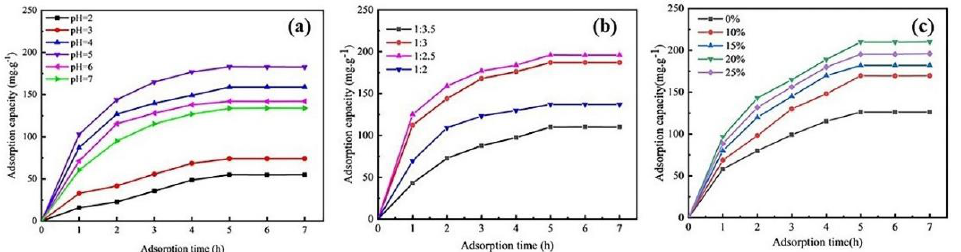
Figure 6. Effects of the solution pH ( a ), PEG/MeOH ratio ( b ), and the amount of monomer of PEG/MeOH ( c ) on the adsorption properties of Cd(II) on the AAM-MSMPM.